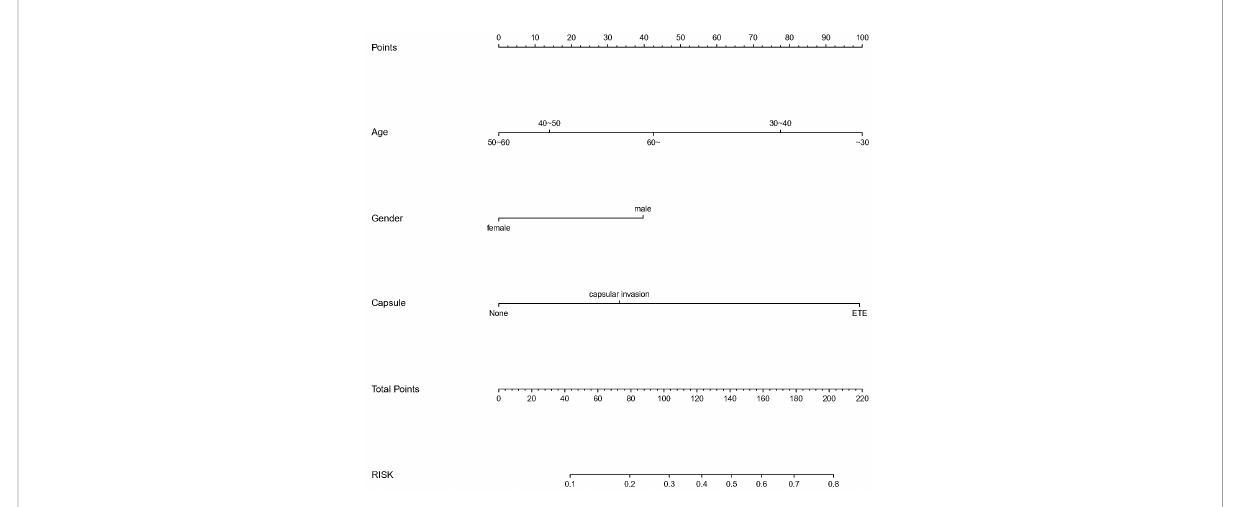
FIGURE 5 Nomogram to predict the risk of contralateral central lymph node metastasis(CLNM)for patients with isthmic papillary thyroid carcinoma (IPTC).CLNM,centrallymphnodemeta stasis; IPTC,isthmicpapillarythyroidcarcinom a.